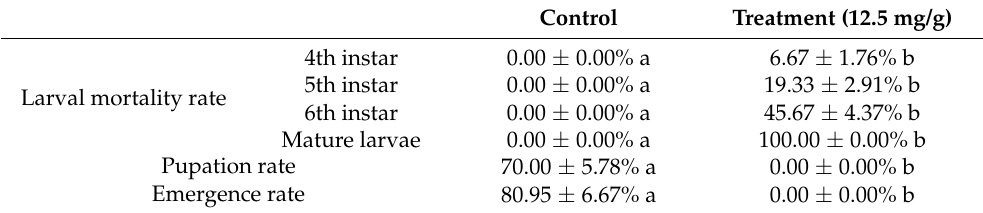
Table 1. The cumulative mortality rate, pupation rate, and emergence rate of H. cunea larvae after rearing on untreated or tannic acid-treated artificial